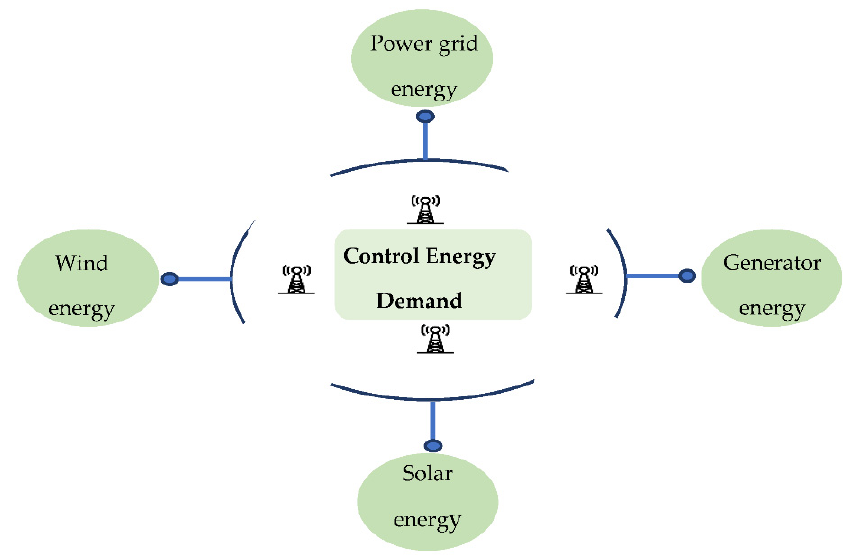
Figure 5. Schematic illustrating concepts of distributed energy resources.